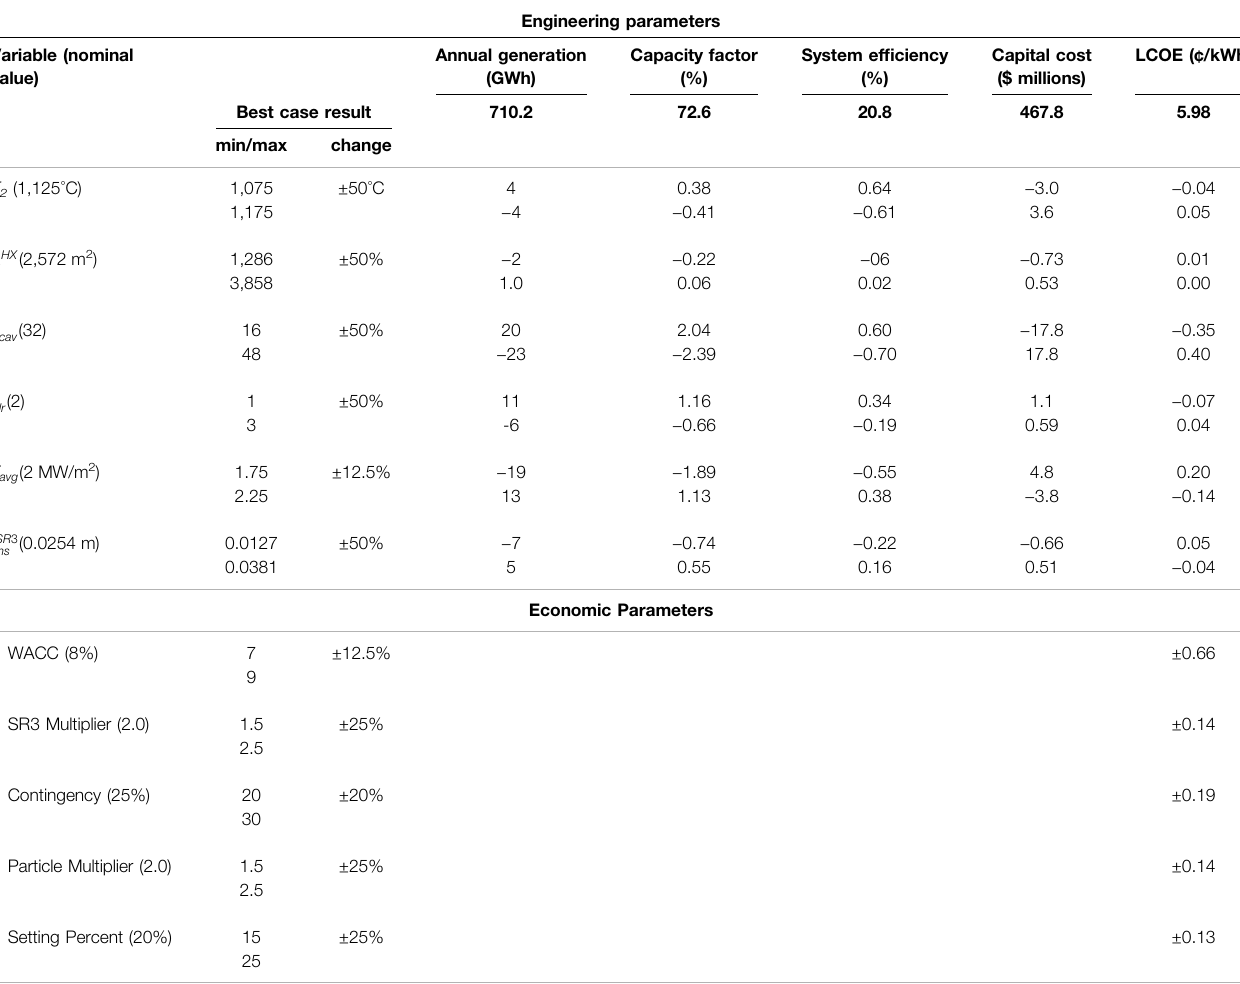
TABLE9| EffectofselecteddesignandeconomicparametersonvariousperformancemetricsandLCOE. T 2 (cid:2) SR3particleoutlettemperature, A HX (cid:2) contactsurfaceareain the heat exchanger, c cav (cid:2) ratio of SR3 cavity interior surface area to aperture area, c lr (cid:2) SR3 ratio of cavity length to cavity radius, F avg (cid:2) Average fl ux density of the receiver aperture, t SR 3 ins (cid:2) thickness of the SR3